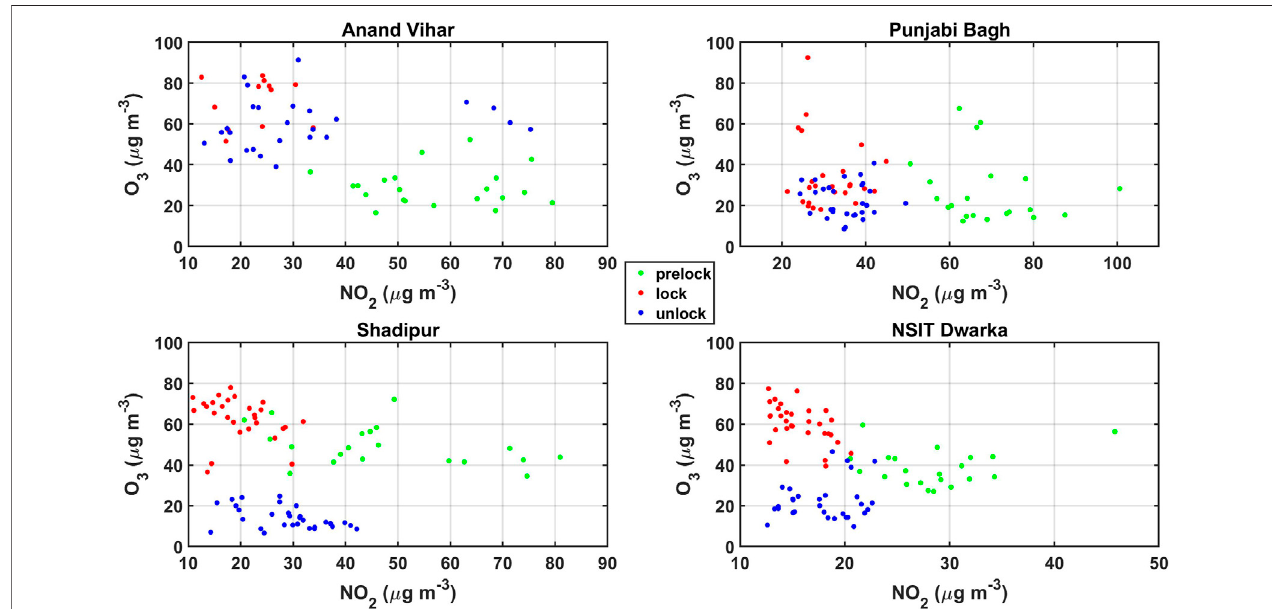
FIGURE 10 | O 3 -NO 2 relationships for different lockdown phases and for different study